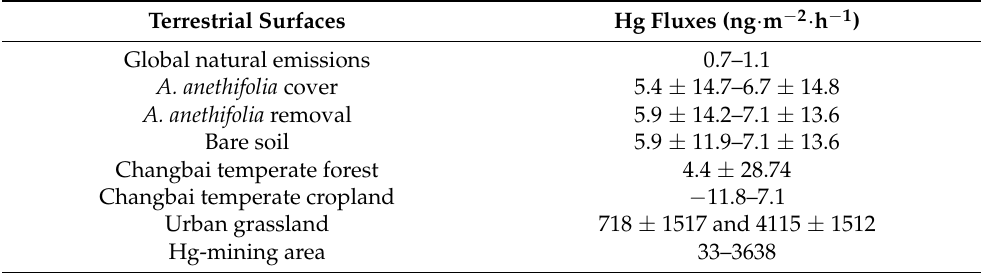
Table 5. Characteristics of the Hg fluxes of different terrestrial surfaces in northeastern